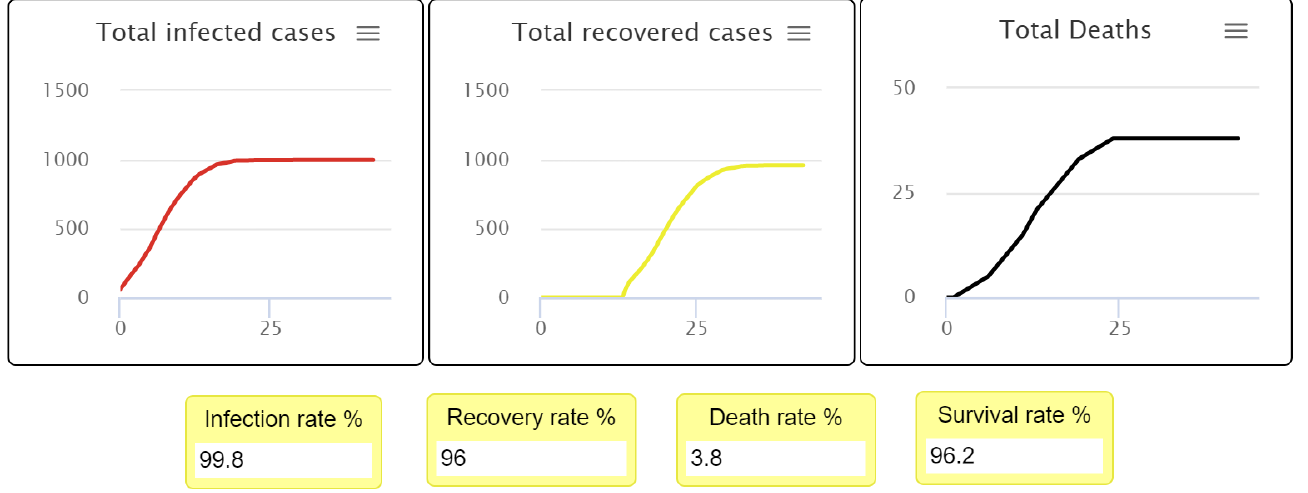
Figure 9. Movement patterns in the first experiment at 0% social distancing.